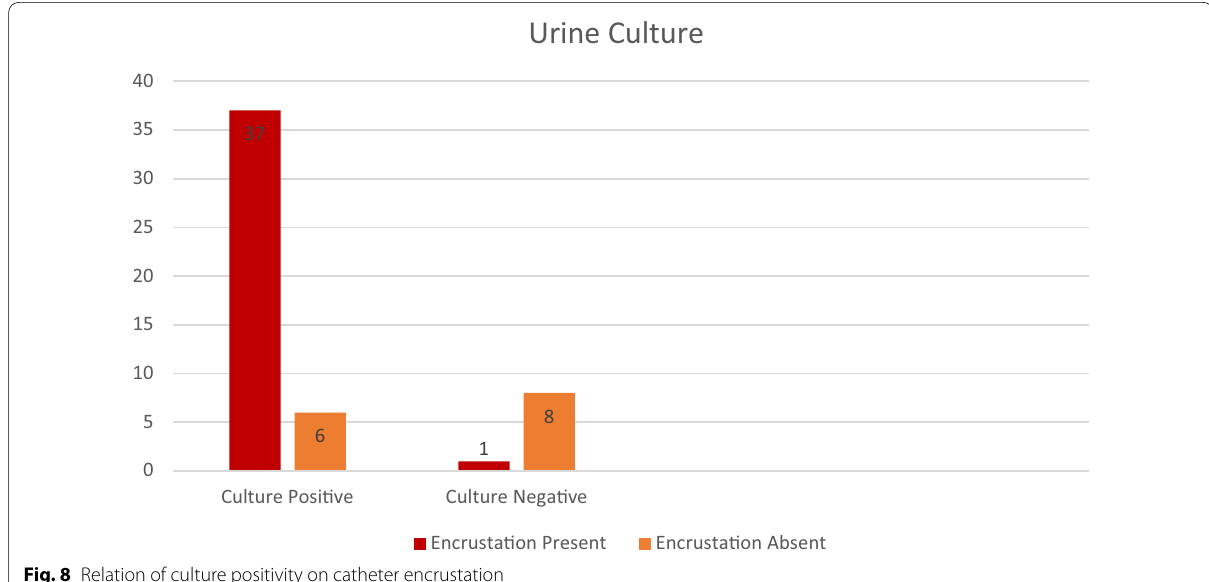
Fig. 8 Relation of culture positivity on catheter